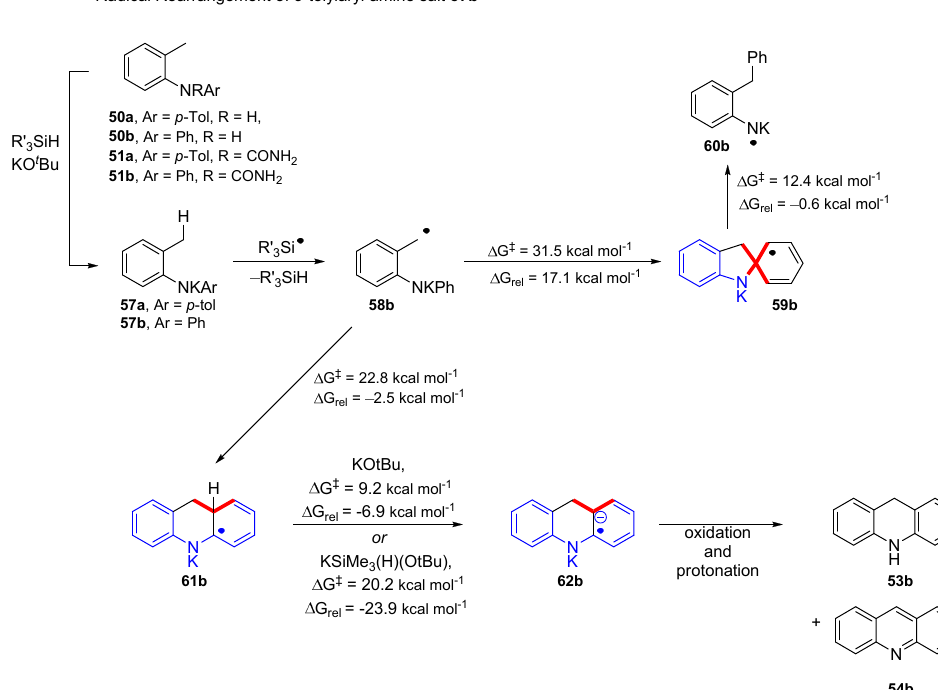
Scheme 10. Energy barriers and relative changes in energy for rearrangement of o -tolylaryl amine salts 57